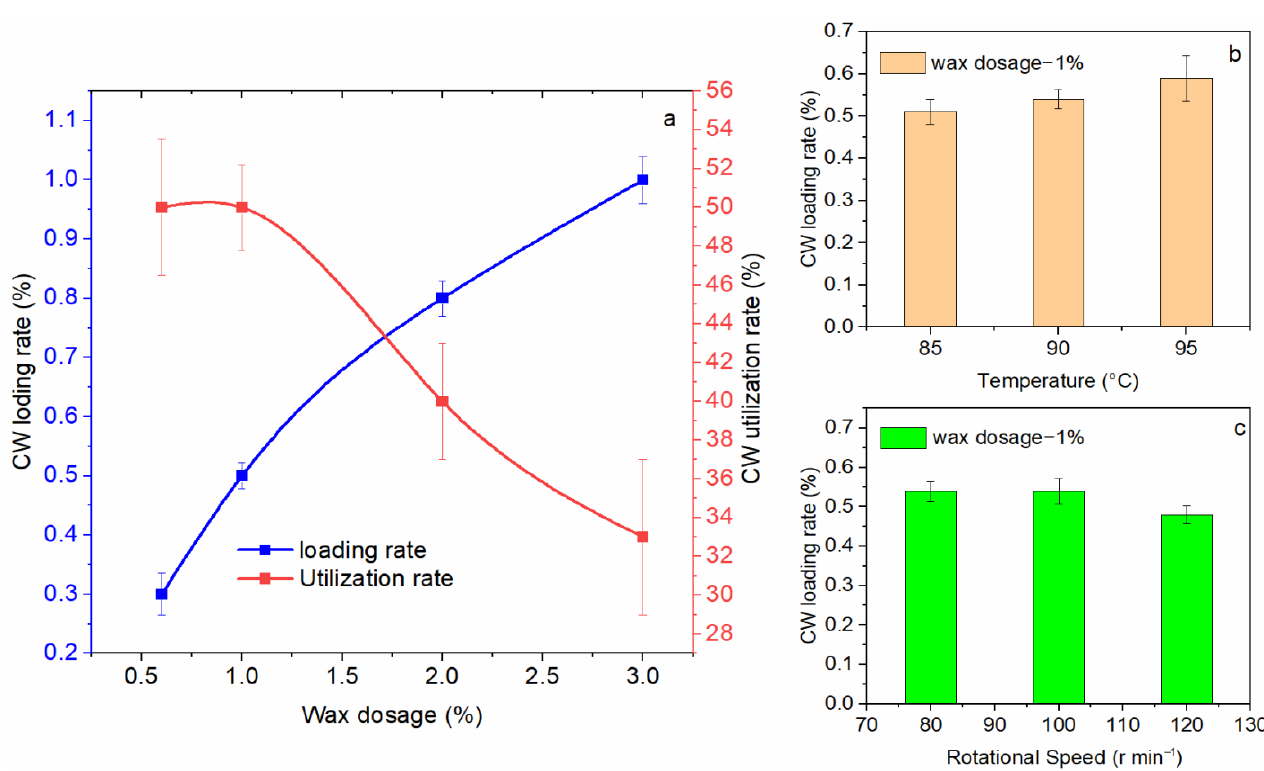
Figure 1. Factors affecting the carnauba wax (CW) loading rate. ( a ) Dosage; ( b ) Temperature; ( c ) Rotational speed.